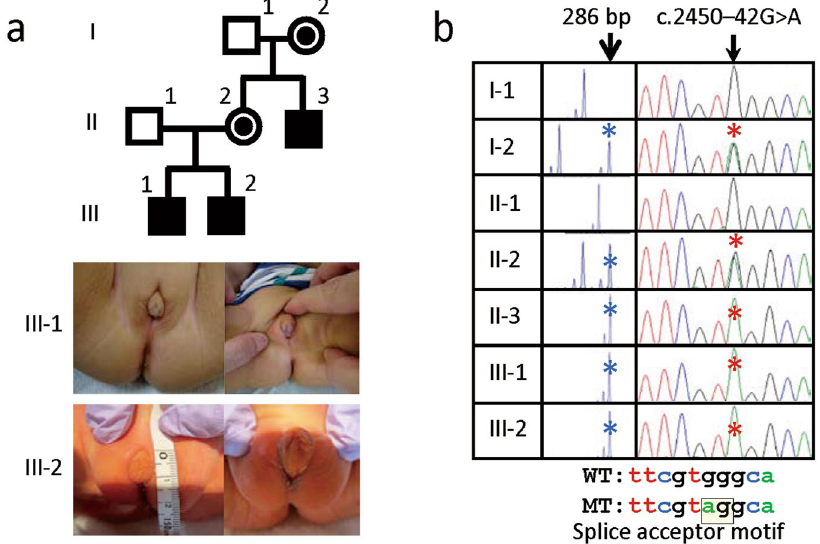
Figure 1. Clinical and genetic findings of this family. ( a ) The pedigree of this family, and external genital findings of the affected boys (III-1 and III-2). ( b ) CAG repeat length polymorphism at exon 1 of AR and c.245–42 G > A variant at intron 6 of AR . The “286 bp” peak and the “A” allele are shared by affected males II-3, III-1, and III-2, and obligatory carriers I-2 and II-2. The c.245–42 G > A variant creates the “AG” splice acceptor motif. WT: wildtype, and MT: